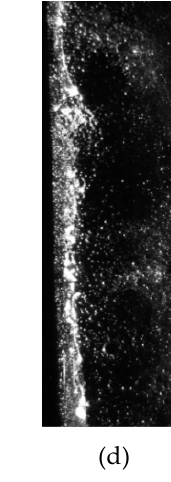
Figure 10. Flow pattern in the riser. ( a ) Bubbly flow; ( b ) slug flow; ( c ) churn flow; ( d ) annular flow.